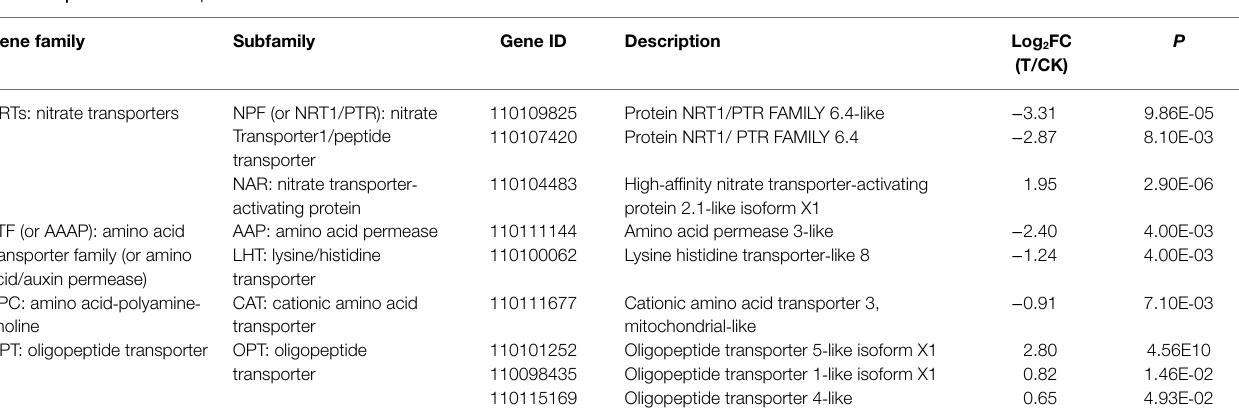
TABLE 1 | DEGs of N